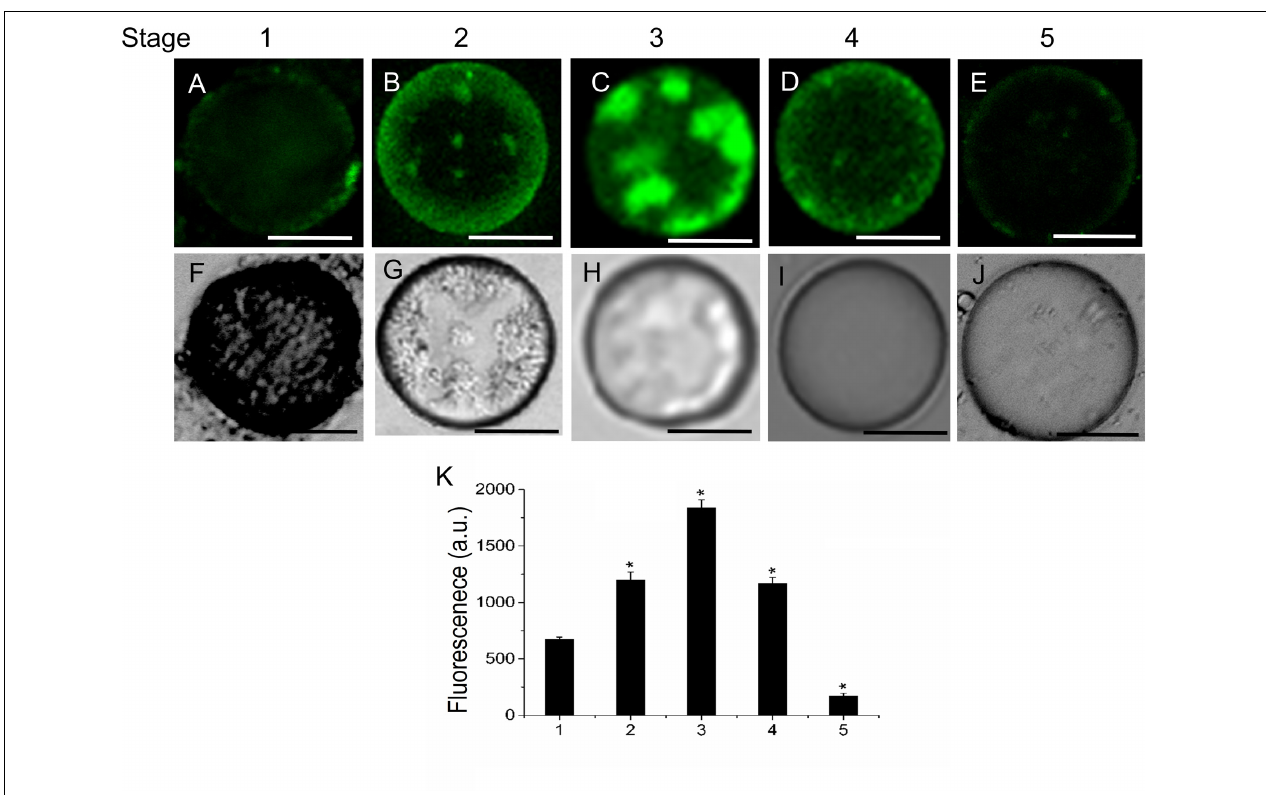
FIGURE 4 | Changes in sphingolipid content in live protoplasts from olive fruit during development. (A–E) BD-SM stained protoplasts from the olive fruit at different stages of development compared to the white light image (F–J) . Scale bars are 10 µ m. (K) Quantification of BD-SM fluorescence in live protoplasts from olive fruit at different stages of development. Data from about 20 protoplasts were acquired per sample, and data were compiled using FV10 4.2 software (Olympus). Columns and bars indicate means ± SD, respectively, from five independent experiments. Statistically significant differences from the preceding point based on unpaired Student’s t -test at P < 0.05 are denoted by